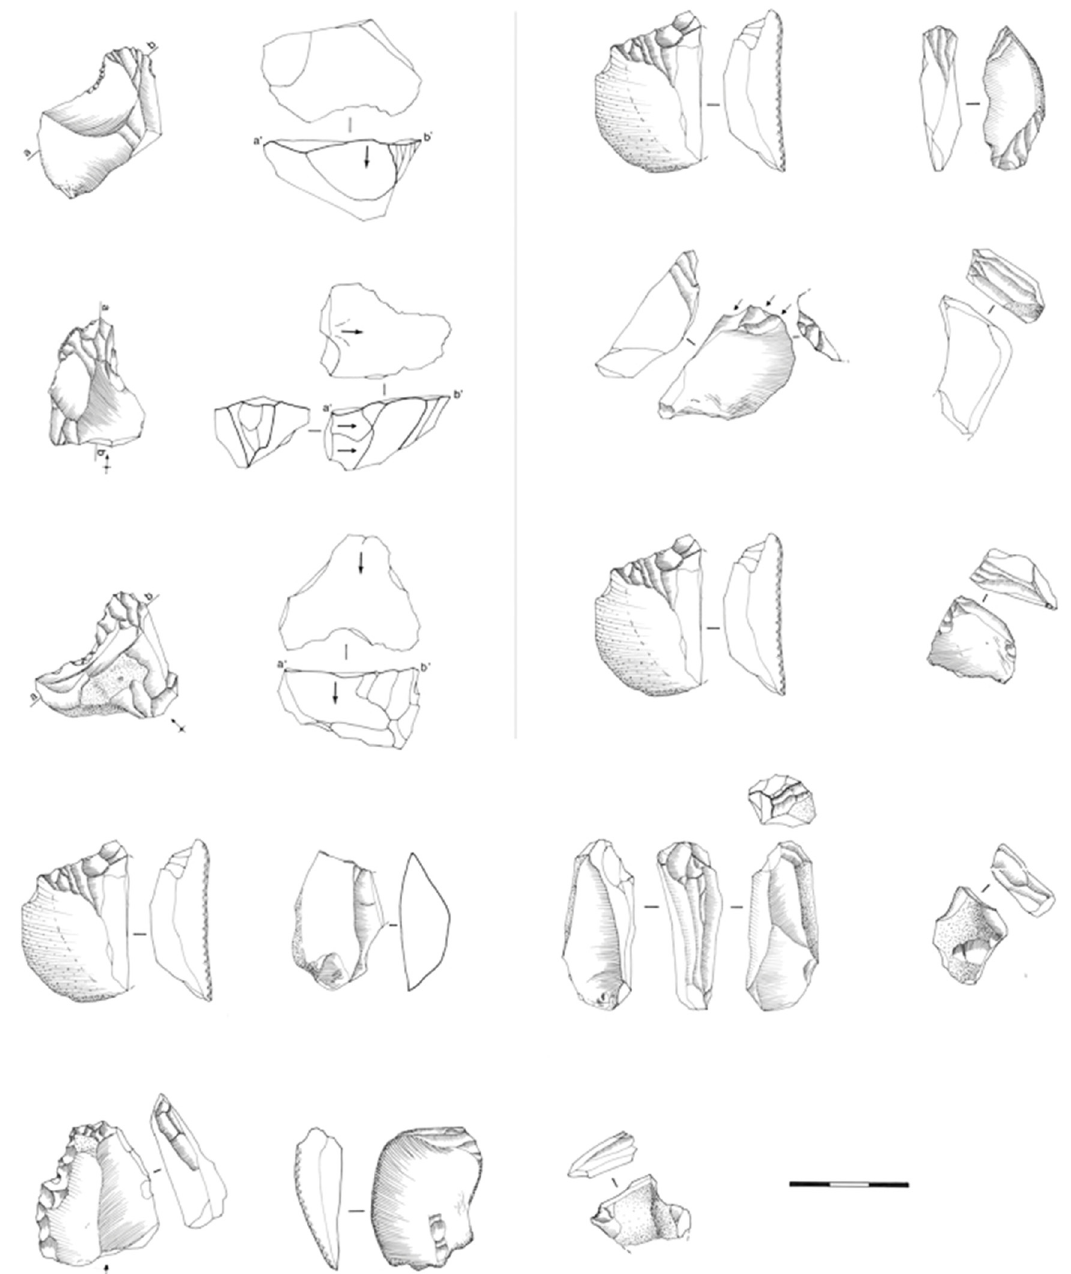
Figure 9: Areeiro 3: cores of carinated and thick - nosed type from which blanks for the Areeiro armatures were produced. Drawing, F.